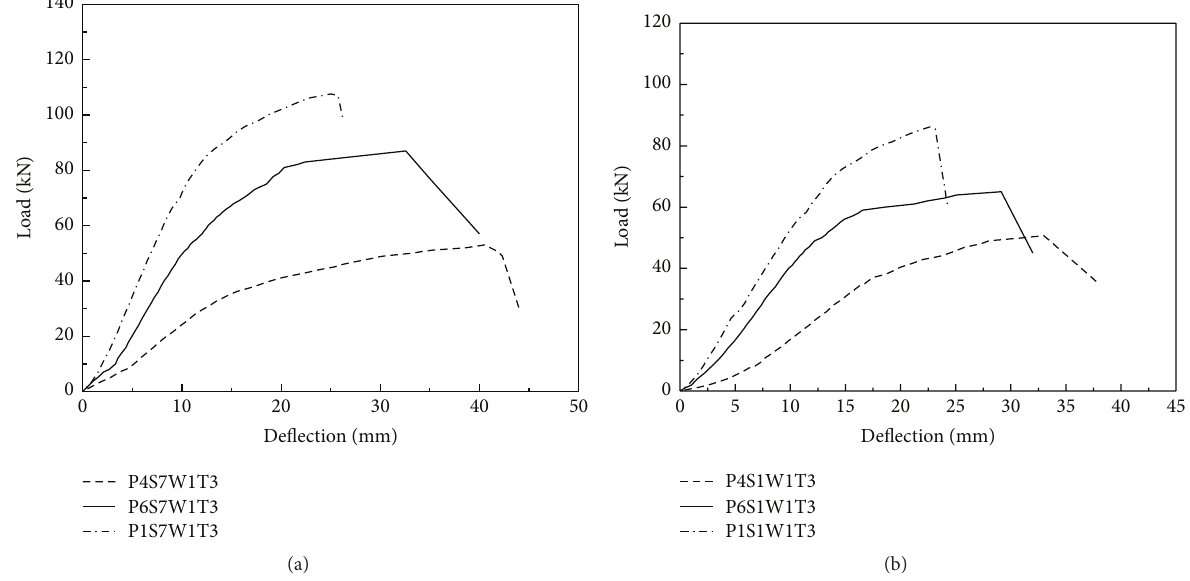
Figure 7: The influence of foam density: (a) 𝑡 𝑠 = 3.2 mm, 𝑠 = 75 mm, and 𝑡 𝑤 = 1.6mm and (b) 𝑡 𝑠 = 3.2 mm, 𝑠 = 125 mm, and 𝑡 𝑤 = 1.6mm.